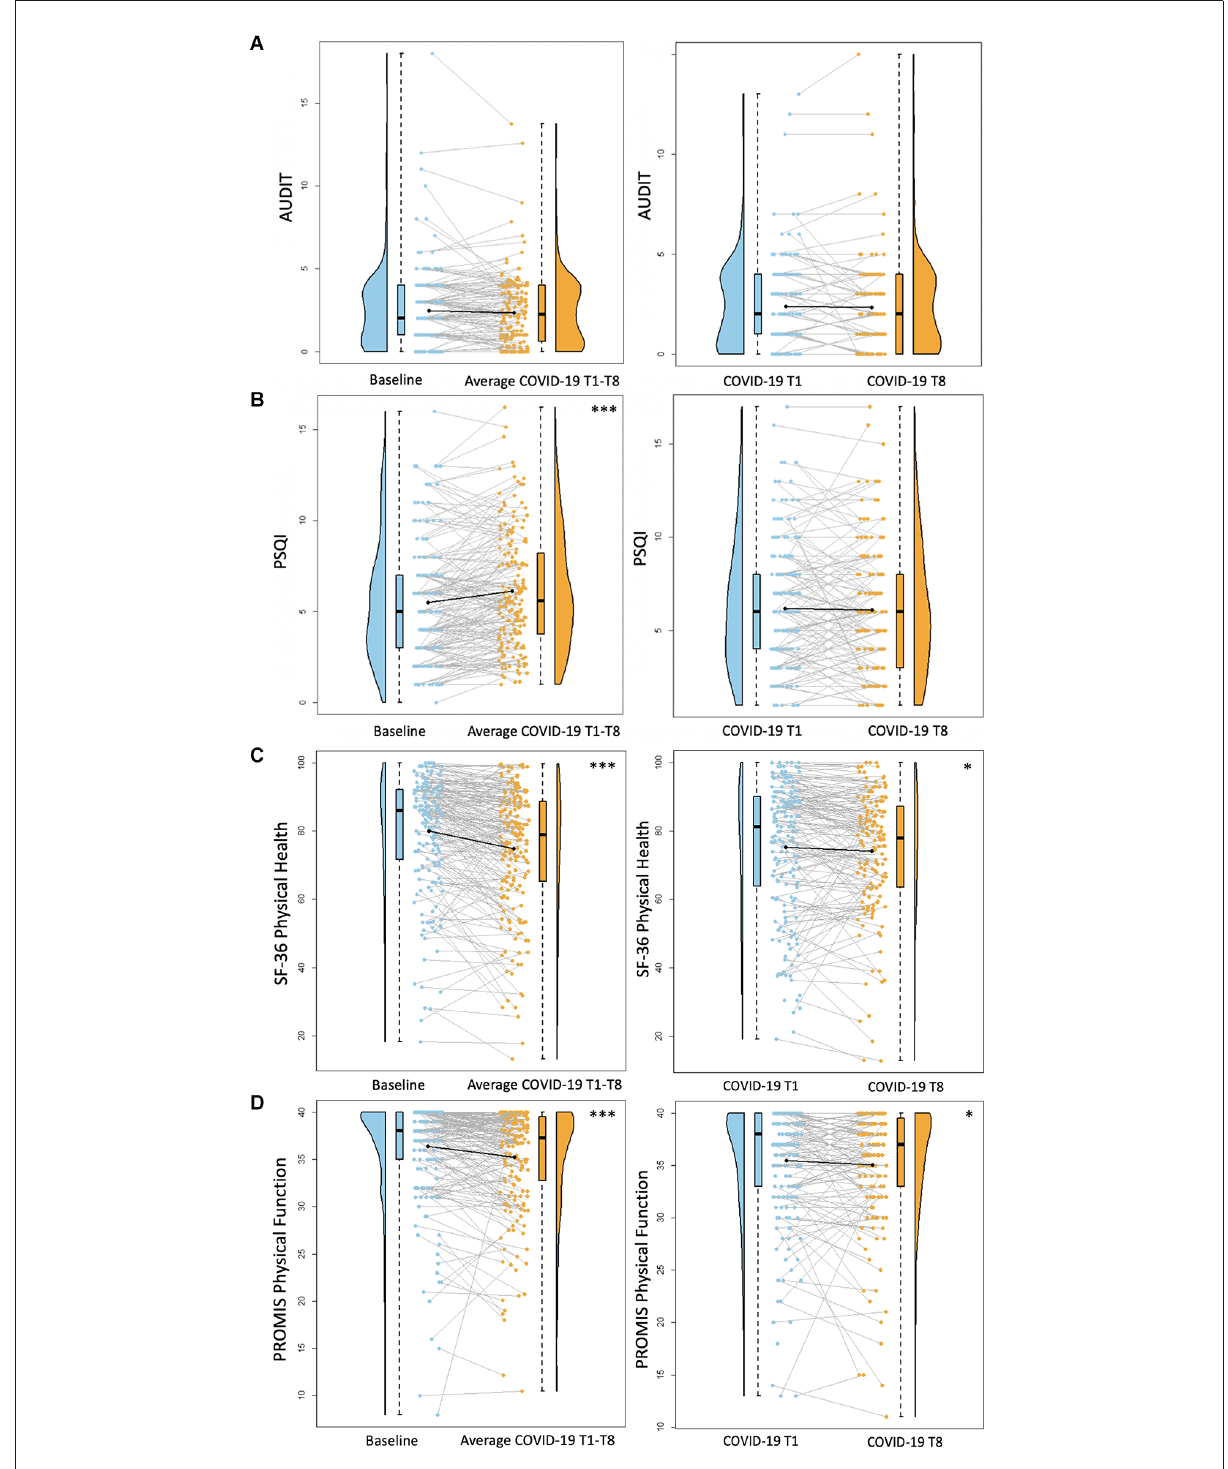
FIGURE1 Health behavior results. Plots depicting the raw distribution of data points collected for (A) Alcohol Use Disorder Identification Test (AUDIT), (B) Pittsburgh Sleep Quality Index (PSQI), (C) Short Form 36 Health Survey Questionnaire (SF-36)—Physical Health Summary, and (D) Patient- Reported Outcomes Measurement Information System (PROMIS)—Physical Function. The plots on the left side of the panel represent change from pre-pandemic baseline to during the pandemic (average of COVID-19 timepoints 1–8), while the plots on the right side of the panel represent change throughout the pandemic (COVID-19 timepoint 1 vs. timepoint 8). ∗ p < 0.05, ∗∗∗ p <